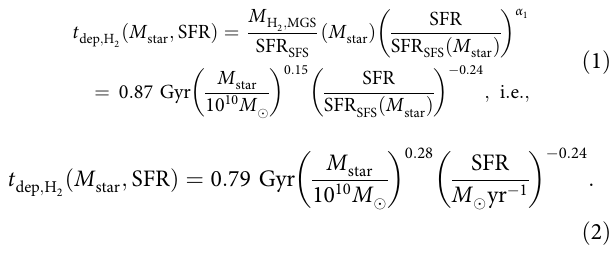
, in galaxies with M star = dep ; H 2 = yr i ¼ A þ α ½ x (cid:2) x (cid:3) þ ½ α (cid:2) α (cid:3) dep ; H 2 1 b 2 1